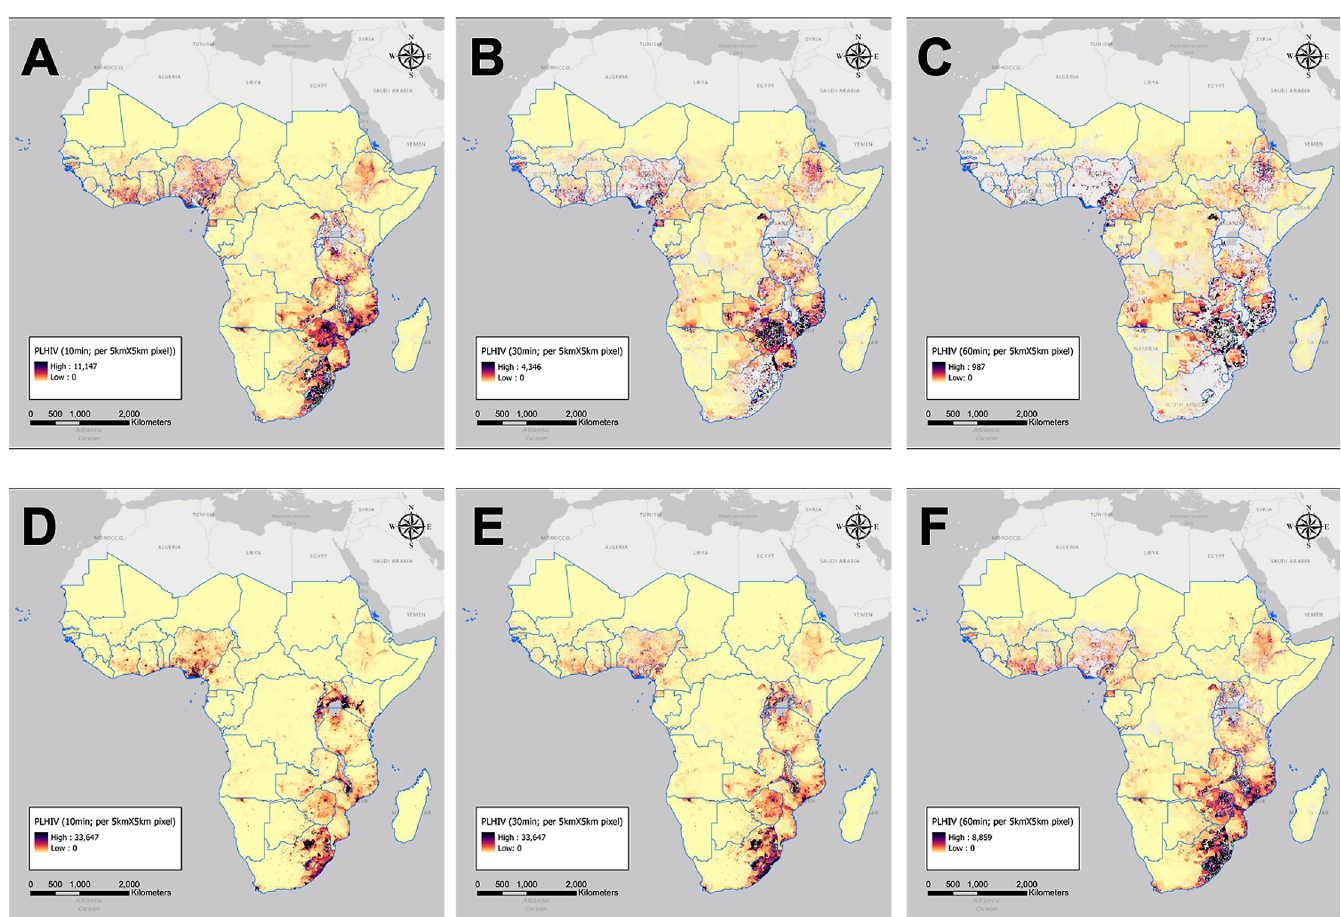
Fig 1. People Living with HIV (PLHIV) in areas with underserved access to health care in sub-Saharan Africa. PLHIV with access to the nearest health care facility using motorized or non-motorized transport at the 10-minute threshold (A. motorized; D. non-motorized), 30-minute threshold (B. motorized and E. non-motorized), and 60-minute threshold (C. motorized; F. non-motorized). Maps were created using ArcGIS by ESRI version 10.5 (http://www.esri.com)